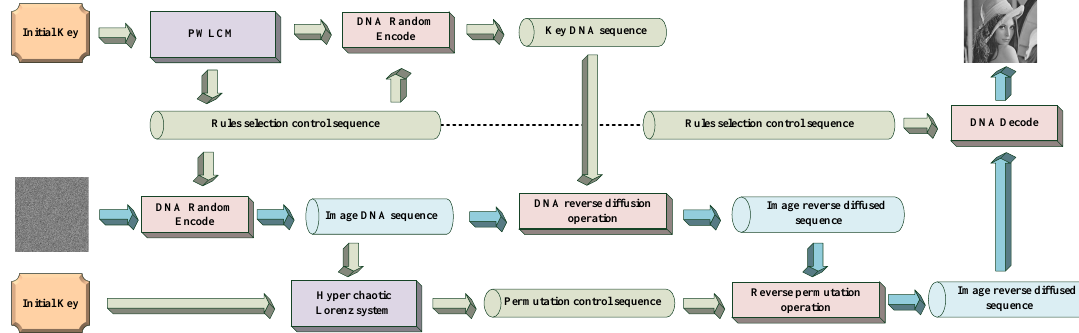
Figure 3. The block diagram of the decryption